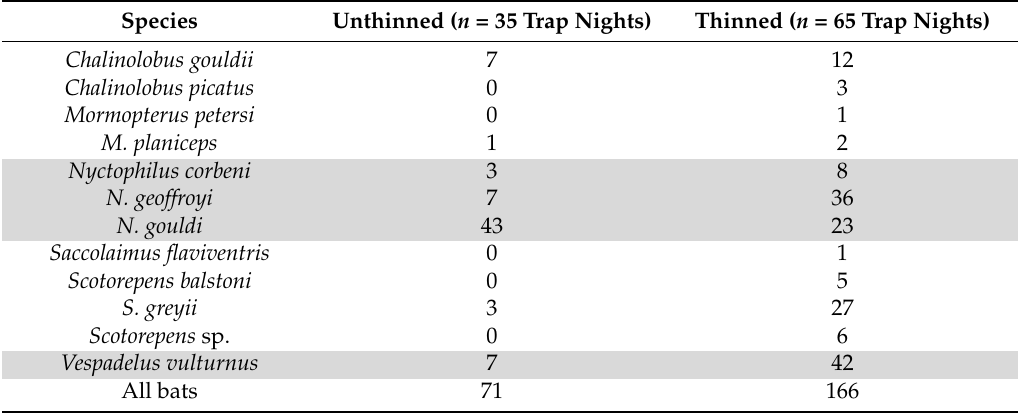
Table 2. Harp trapping data for experimental unthinned and thinned treatments over two years of trapping (2016 and 2017). Grey shading indicates species that were radio-tracked.